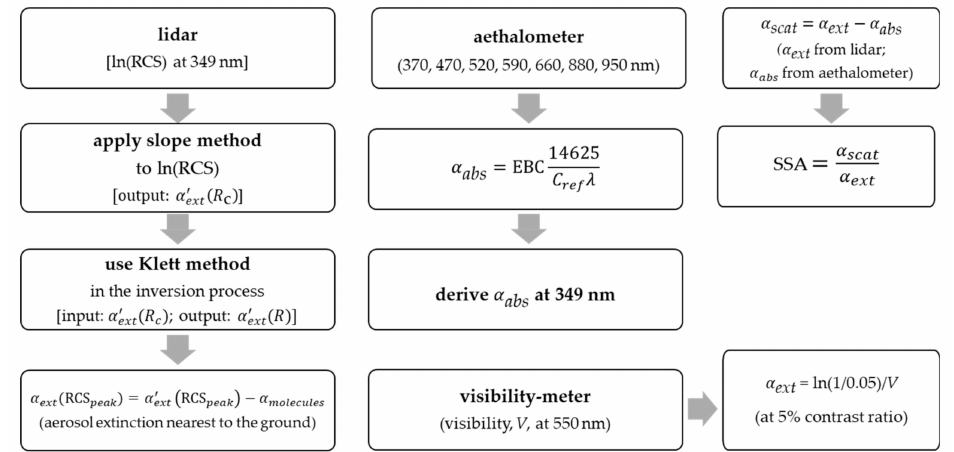
Figure4. Processflowinderivingtheaerosolopticalproperties( α ext andSSA)fromdi ff erentinstruments used in this